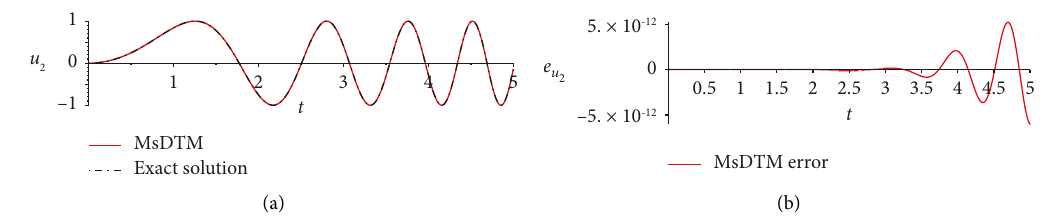
Figure 8: The approximate solution component u